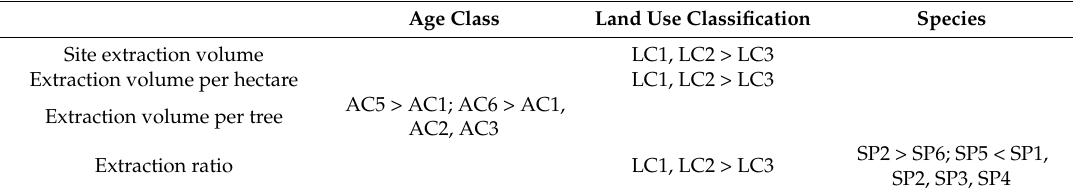
Table 8. Post hoc test with Duncan’s